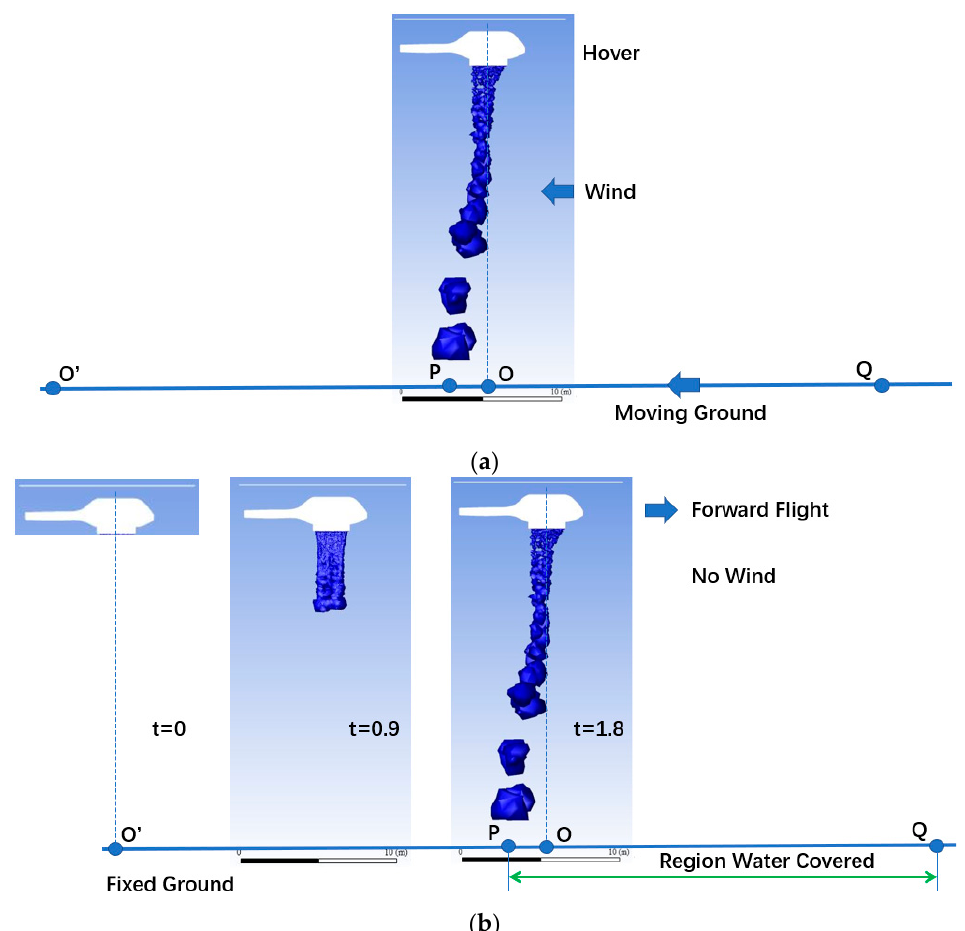
Figure 27. Water being dumped out of a helicopter tank and the distribution interval of water on the ground. ( a ) Helicopter hovering against the wind with the ground moving in the wind direction at wind speed. ( b ) Helicopter flying forward (forward flight speed = wind speed in a) with no wind and the ground fixed.